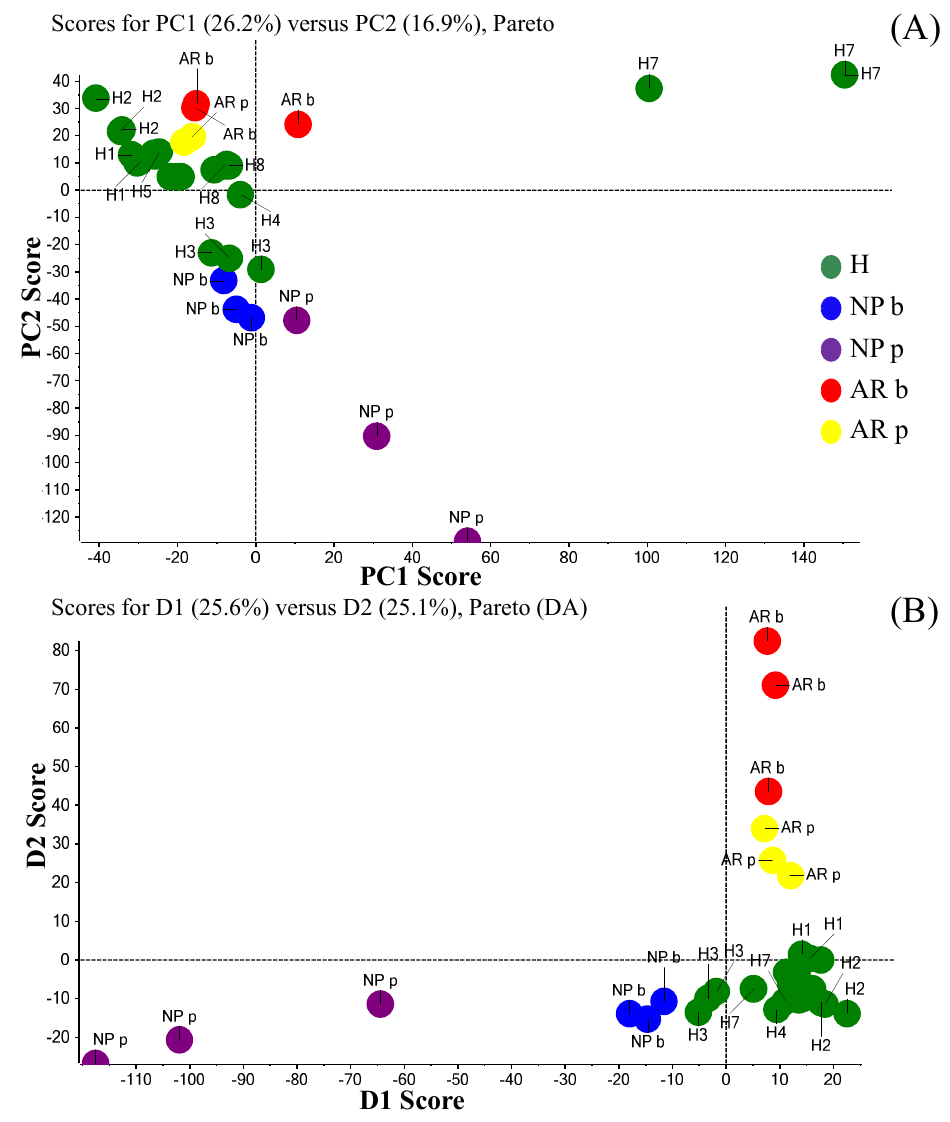
Figure 5. Unsupervised PCA scores plot (panel ( A )) and the corresponding PCA-DA (supervised) scores plot (panel ( B )) to visualize NF samples clustering. The green dots represent the NF sample obtained from eight healthy subjects (H). Red and yellow dots represent the patient with AR before and after treatment with azelastine/fluticasone (AR b and AR p respectively). Blue and violet dots represent the NARMA patient with NP before and after polypectomy (NP b and NP p, respectively). The three colored dots for each individual subject category represent the three independent intra-day replicate analyses for NF samples.